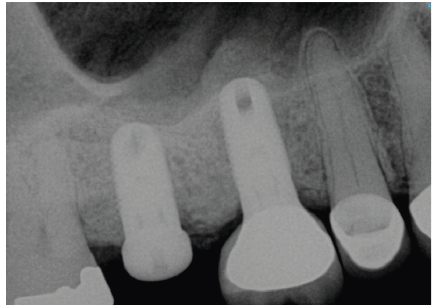
Figure 11: The same protocol of extraction, ridge preservation and subsequent implant placement, was followed successfully for site #2. The implant at site #3 did not show any signs of infection or inflammation, radiographically nor